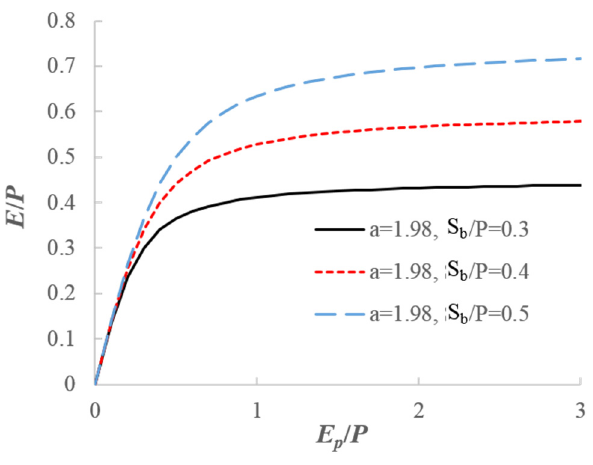
Figure 10. The obtained two-parameter, long-term water balance equation from the developed PDM–CN model.